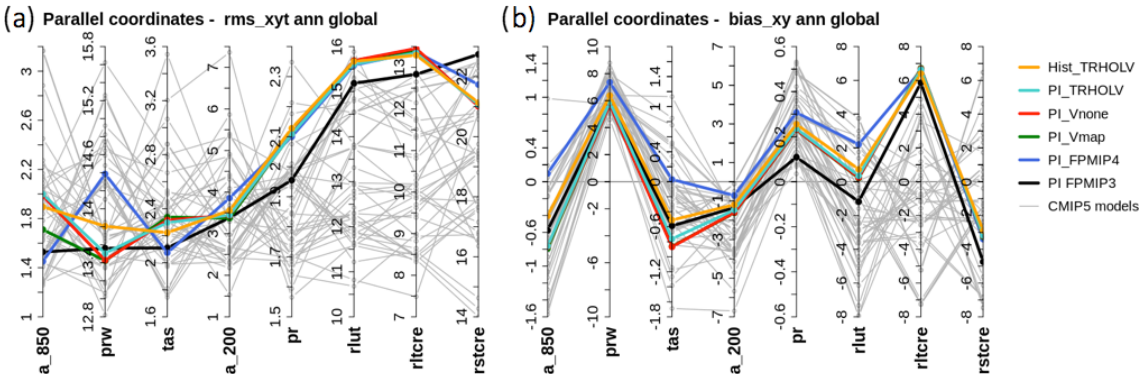
Figure 3. (a) Spatiotemporal root mean square differences (rms_xyt) and (b) annual mean global model bias (bias_xy) computed on the annual cycle (12 climatological months) over the globe for the different preindustrial simulations considered in this paper (colored lines) and individual simulations of the CMIP5 multi-model ensemble (gray lines). The metrics for the different variables are presented as parallel coordinates, each of them having their own vertical axis with corresponding values. In these plots, “ta” stands for temperature ( ◦ C) with “s” for surface (850 and 200 for 850 and 200hPa, respectively), “prw” for total water content (gkg − 1 ), “pr” for precipitation (mmd − 1 ), “rlut” for outgoing long-wave radiation (Wm − 2 ), and “rltcre” and “rltcre” for the cloud radiative effect at the top of the atmosphere in the shortwave and long-wave radiation, respectively (Wm − 2 ). See Appendix A for details on the metrics.